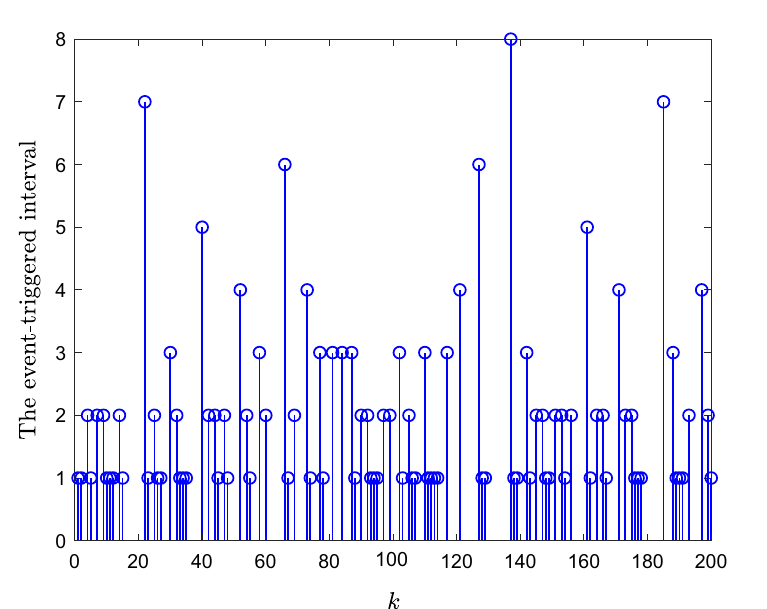
Fig. 3 The event-triggered